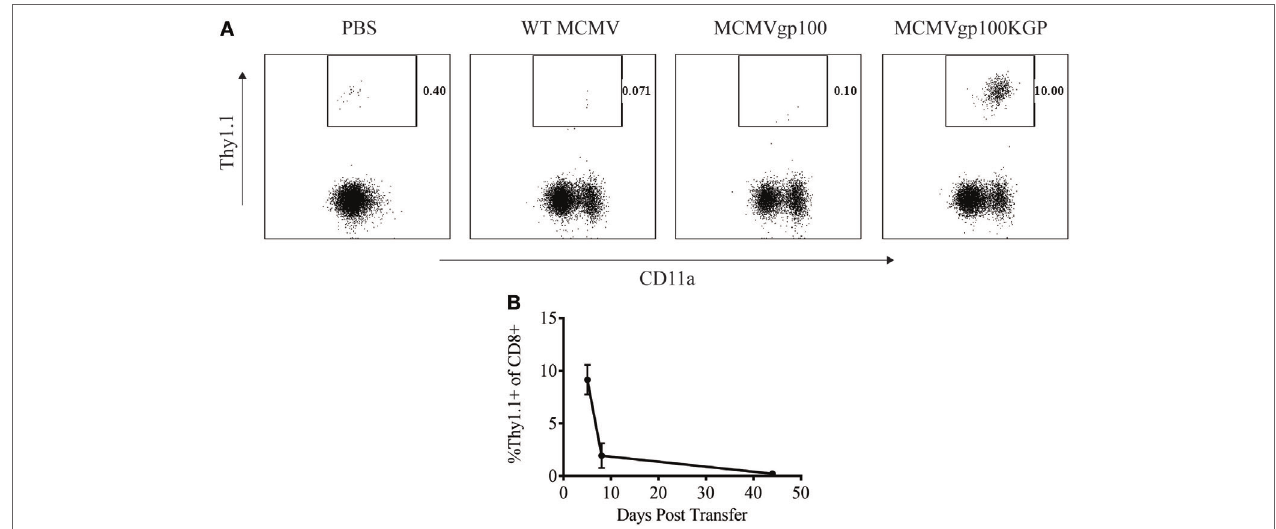
FigUre 3 | MCMVgp100KGP maintains adoptively transferred PMEL cells at low frequency long-term. Wild-type (WT) Thy1.2 + mice received 10 5 Thy1.1 + PMEL cells i.v. followed by mock vaccination with PBS or vaccination with 10 5 PFU WT murine cytomegalovirus (MCMV), MCMVgp100, or MCMVgp100KGP i.p. Peripheral blood was collected at various time points after transfer and processed for flow cytometry. (a) Representative plots from peripheral blood of mice receiving PMEL transfer and vaccination 5 days prior. Gated on CD8 + cells. (B) Frequency of Thy1.1 + of CD8 + cells over time in peripheral blood of mice vaccinated with MCMVgp100KGP. n = 4–5 mice/group. Data are representative of two independent